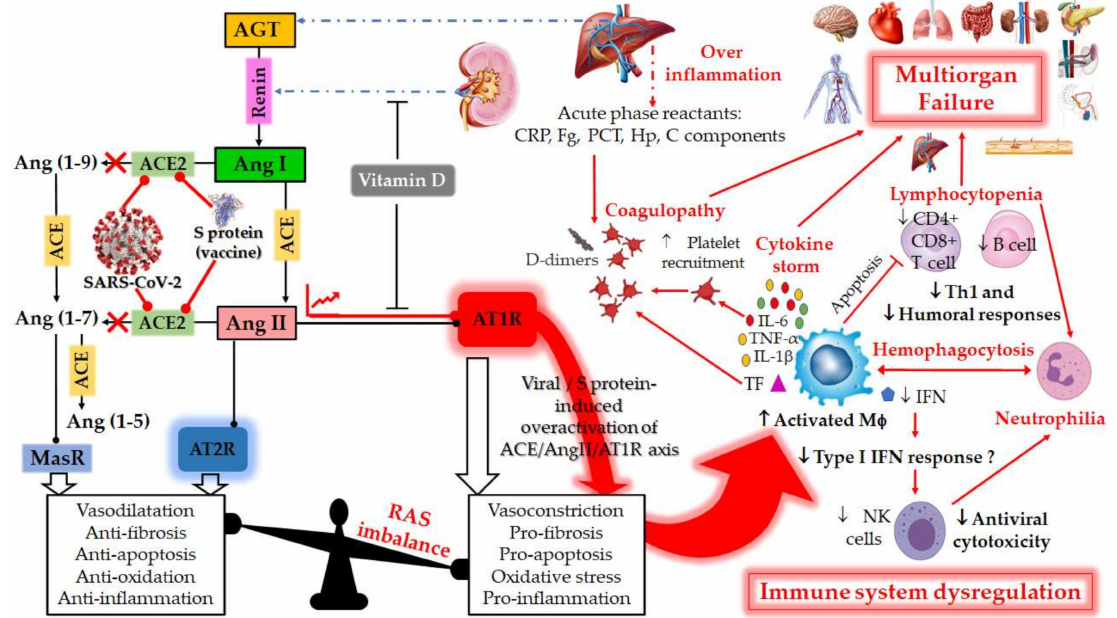
Figure 1. Schematic diagram of the dysregulation in the Renin–Angiotensin System (RAS) and the host immune system caused by the severe acute respiratory syndrome coronavirus 2 (SARS-CoV-2) or by vaccination with mRNA encoding SARS-CoV-2 spike (S) glycoprotein. RAS is a metabolic cascade which supports a series of enzymatic reactions in which the liver secreted AGT is transformed into Ang I by renin, which is a protease secreted by juxtaglomerular kidney cells in response to decrease in blood pressure or sodium load in the distal convoluted tubule. Ang I is subsequently converted to Ang II by ACE which can bind to the AT1R to exert several actions, such as vasoconstriction, pro-fibrosis, pro-apoptosis, oxidative stress and pro-inflammation. ACE2 counterbalances Ang II/AT1R effects by cleaving Ang I and Ang II into Ang-(1–9) and Ang-(1–7), respectively. Ang-(1–9) is also converted into Ang-(1–7), a negative regulator of the RAS, which binds to the MAS receptor to exert protective actions of vasodilatation, anti-fibrosis, anti-apoptosis, anti-oxidative and anti-inflammation. Ang-II can also bind to AT2R to counteract the aforementioned effects mediated by AT1R. The balance between the Ang II/AT1R axis and the ACE2/Ang (1–7)/MasR axis is therefore maintained under physiological conditions. However, during SARS-CoV-2 infection or upon receiving a spike protein-based vaccine, the viral Spike (S) glycoprotein binding to ACE2 receptor induces overactivation of the ACE/Ang II/AT1R axis. This event prevents normal Ang II degradation, the excess of which leads to AT1R overactivation and RAS system imbalance. Such an imbalance is